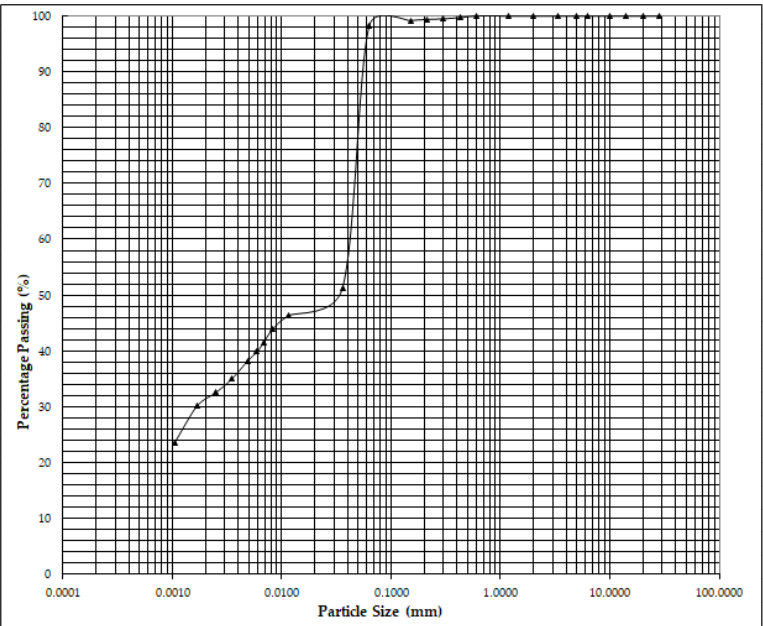
Figure 2. Marine clay soil distribution curve.